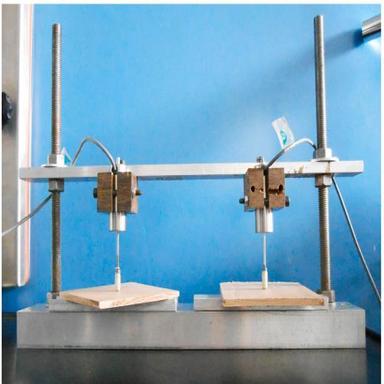
Deflection measurement support for the LVDT.